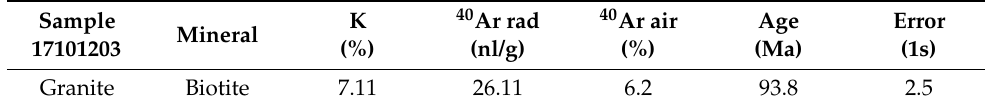
Table 1. The results of biotite K–Ar age of the granite.